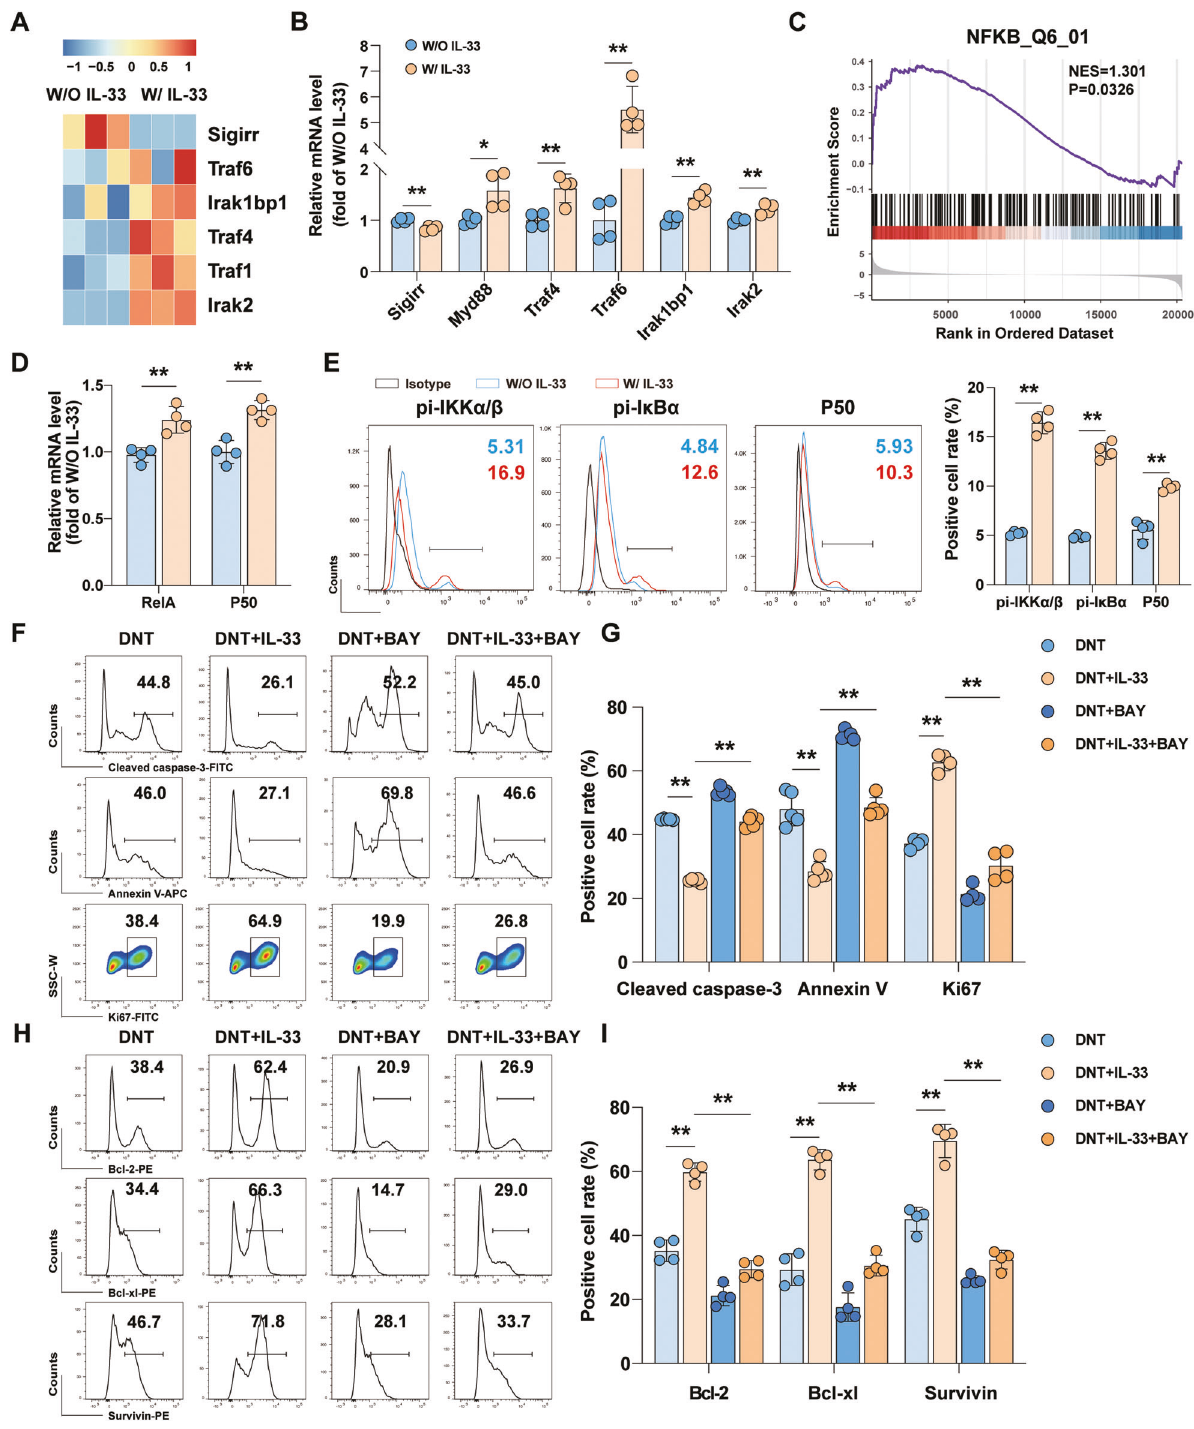
Fig. 3 IL-33 promoted DNT cells survival via the NF- κ B signaling pathway. A The data were presented as a heatmap exhibiting differential gene expression related to IL-33 signaling. B Genes mRNA expression was con fi rmed by real-time PCR after IL-33 stimulation ( n = 4/group). C GSEA of a NFKB_Q6_01 gene set in DNT cells stimulated with IL-33 compared with control DNT cells. D Relative mRNA expression of NF- κ B signaling pathway-related genes ( n = 4/group). E Flow cytometric and statistical analysis of P50 protein expression, and the phosphorylation of IKK α / β and I κ B α protein expression in DNT cells with or without IL-33 stimulation for 48 h ( n = 4/group). Representative fl ow cytometry plots ( F ) and statistical analysis ( G ) of cleaved caspase-3 + , Annexin V + and Ki67 + DNT cells percentages after incubation with an NF- κ B signaling inhibitor (BAY 11-7082) with or without IL-33 stimulation for 48 h ( n = 4 or 5/group). Representative fl ow cytometry plots ( H ) and statistical analysis ( I ) of the Bcl-2 + , Bcl-xl + , and Survivin + DNT cells percentages after incubation with an NF- κ B signaling inhibitor (BAY 11- 7082) with or without IL-33 for 48 h ( n = 4/group). Data in B , D and E were analyzed using unpaired Student ’ s t test with or without Welch ’ s correction depending on the F -test results. Data in G and I were analyzed using repeated measures One-way ANOVA post hoc Turkey ’ s test. The data are represented as the mean ± SD. * p < 0.05, ** p < 0.01. See also Fig.